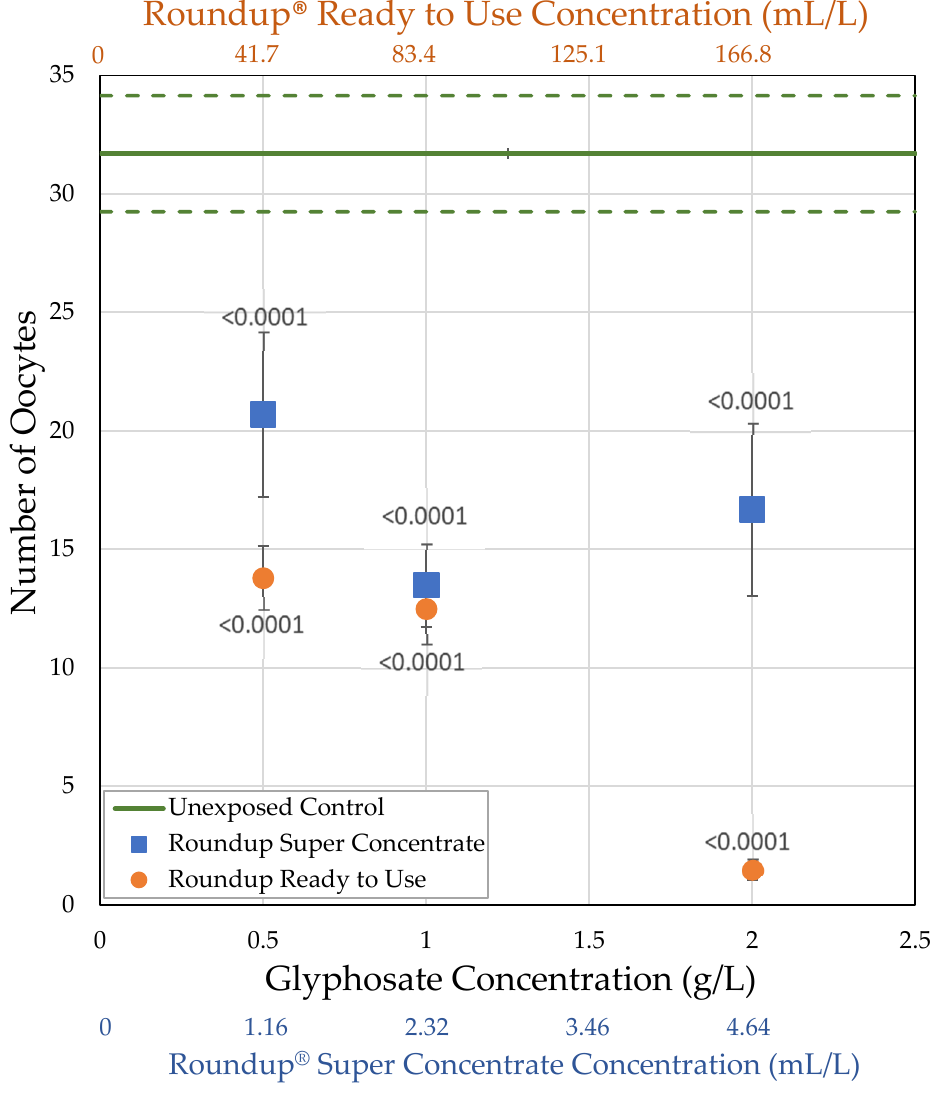
Figure 7. Oocytes of D. melanogaster females exposed to herbicide within 2 h of eclosion for 7 days, compared to the oocytes of females exposed to the control medium (± std. error).